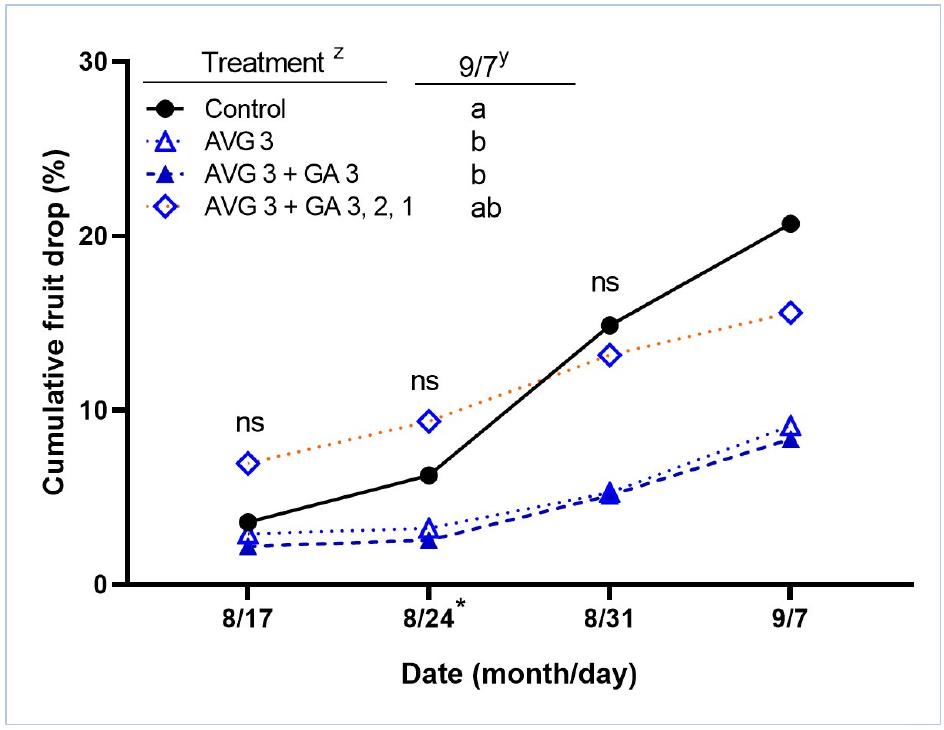
Figure 4. Effects of AVG and GA 4+7 on fruit drop of ‘Crimson Gala’ apples ( n = 6). Z, numbers indicate the numbers of weeks before harvest; GA, GA 4+7 . Y means not sharing any letters are significantly different by the Tukey’s HSD test ( p < 0.05). *, date of harvest.